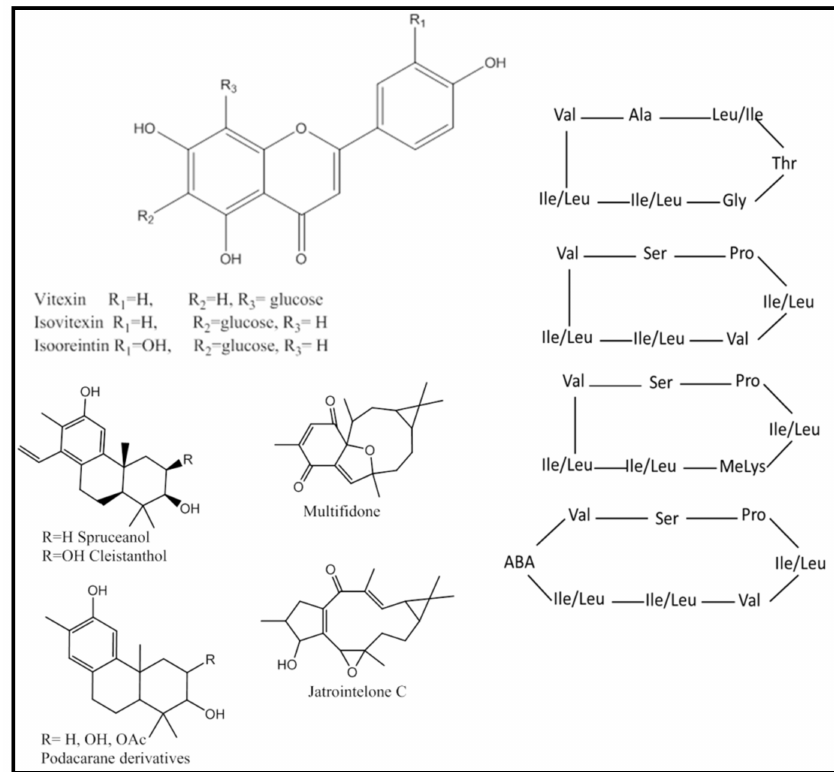
Figure 6. Structures of selected compounds annotated in J. integerrima extract including flavonoids, peptides, and